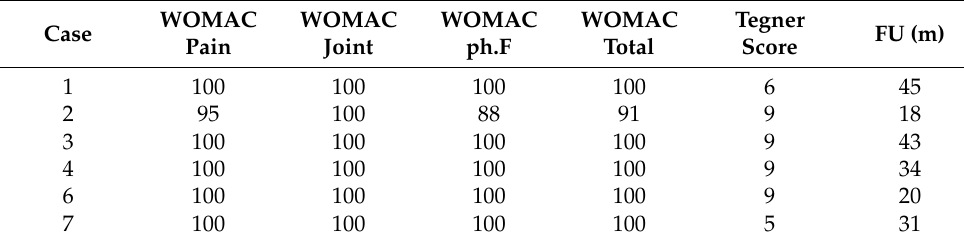
Table 2. Patient-reported outcomes at final